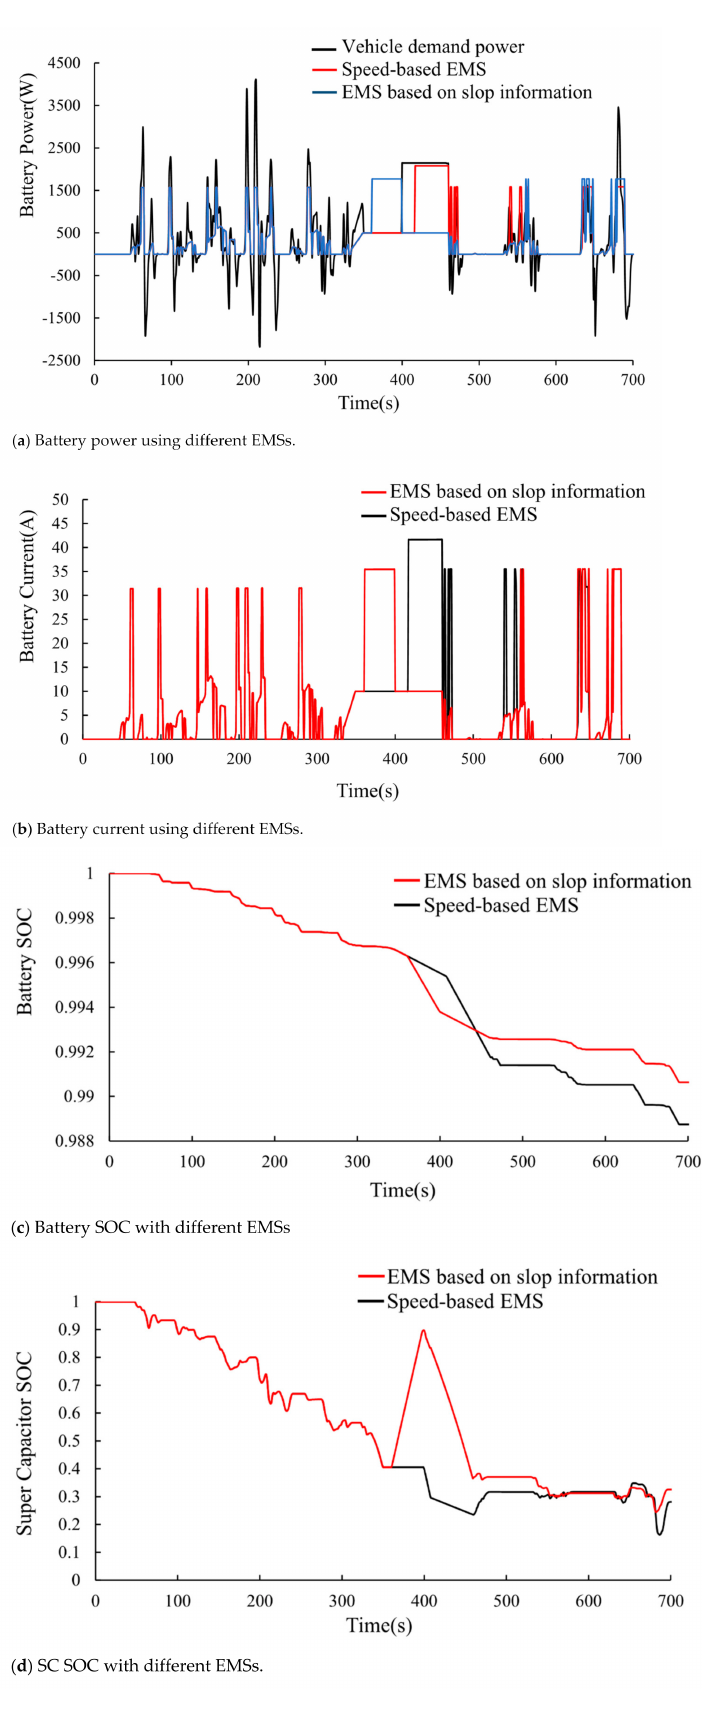
Figure 7. Simulation results of uphill working